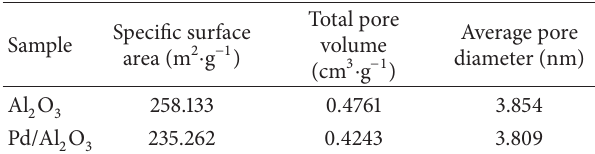
Table 1: Specific surface area, total pore volume, and pore diameter of Al 2 O 3 and 1% Pd/Al 2 O 3 .